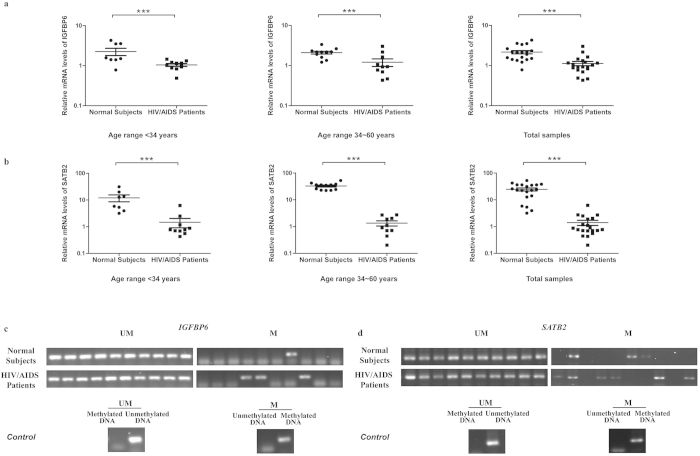
Decreased expression of target genes between 20 HIV/AIDS patients with similar viral load and 20 age- and sex-matched normal subjects.All HIV/AIDS patients did not receive any antiretroviral therapy. The mRNA expression levels of IGFBP6 (a) and SATB2 (b) were analyzed in 3 groups: age under 34 years (8 normal subjects vs 12 HIV/AIDS patients), age between 34 and 60 years (12 normal subjects vs 8 HIV/AIDS patients) and all samples (20 normal subjects vs 20 HIV/AIDS patients). Round dots represent normal control; Rectangle dots represent HIV/AIDS patients. The y-axis is plotted on a logarithmic scale. *** P < 0.005; ** P < 0.01; * P < 0.05, Mann-Whitney U test. Methylation status of IGFBP6 (c) and SATB2 (d) were checked by MSP. M, PCR for CpG-methylated DNA; UM, PCR for CpG-unmethylated DNA. Fully uncut gel images are shown in Supplementary Figures.